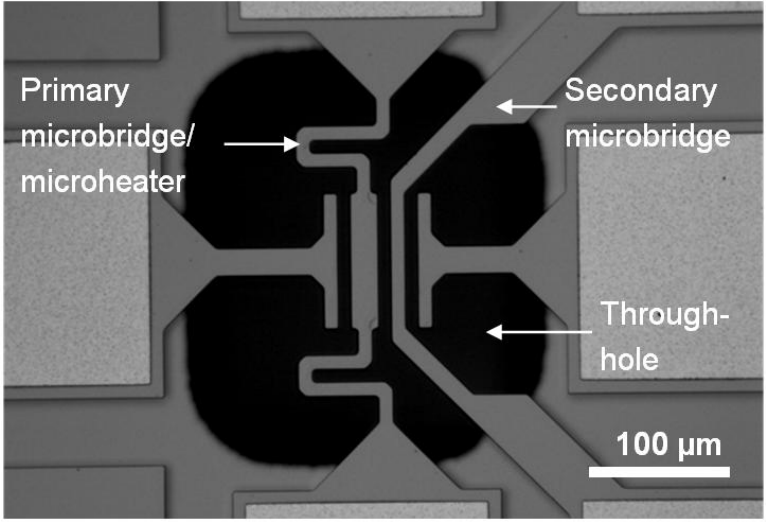
Figure 1. Optical micrograph of microsystem for carbon nanotube (CNT) growth, consisting of two suspended silicon microbridges. CNTs grow from the microheater (primary microbridge), guided by an electric field, and connect to the secondary microbridge. The through-hole in the Si substrate facilitates transmission